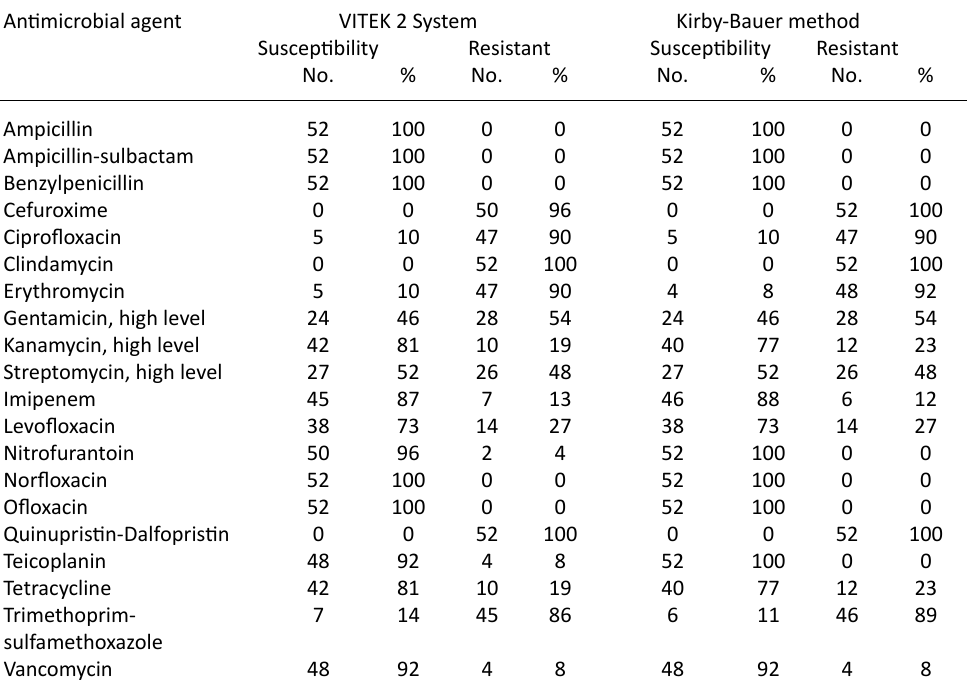
Table 2. Susceptibility of E. faecalis against antimicrobial agents using Vitek 2 cards with a reference of Kirby-Bauer method Antimicrobial agent VITEK 2 System Kirby-Bauer method